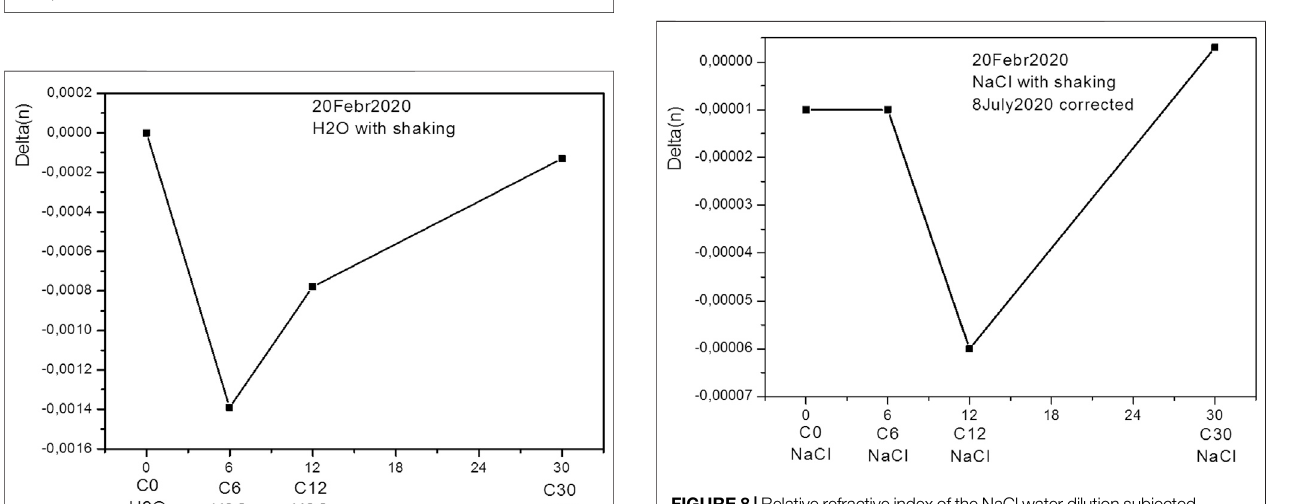
FIGURE 5 | The example of the ( δ n ) time dependence for one of the sample.